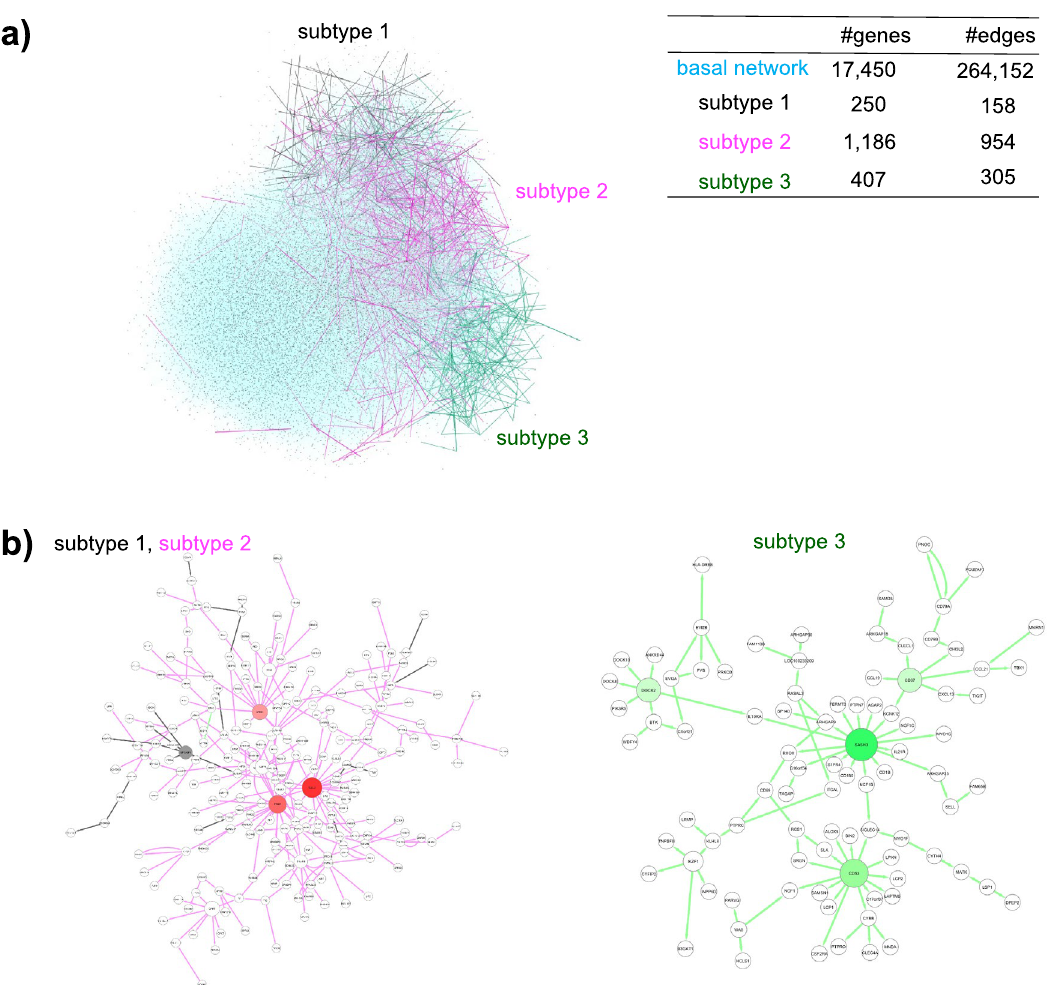
Figure 4. Visualization of subtype-specific subnetworks in the STAD dataset. ( a ) Subnetworks of subtype- specific edges were highlighted with the basal network (blue). ( b , c ) The biggest connected component in the subnetwork of subtype-specific edges in each subtype. Edges and nodes were colored by each subtype: subtype 1 (gray), subtype 2 (magenta), and subtype 3 (green). Colored nodes were hub nodes in each subtype and the color gradient represents the outdegree of